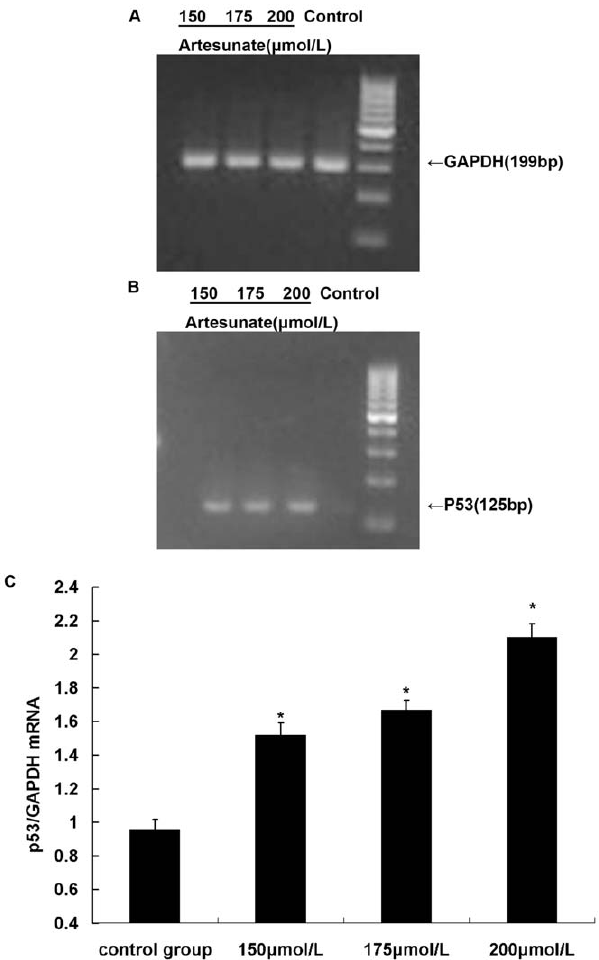
Figure 6. Effects of Artesunate on P53 mRNA expression (n=6). After HSCs acted by Artesunate 150 m mol/L, 175 m mol/L, 200 m mol/L, Compared with control group, the expression of P53 mRNA increased significantly in Artesunate group, * P , 0.05.